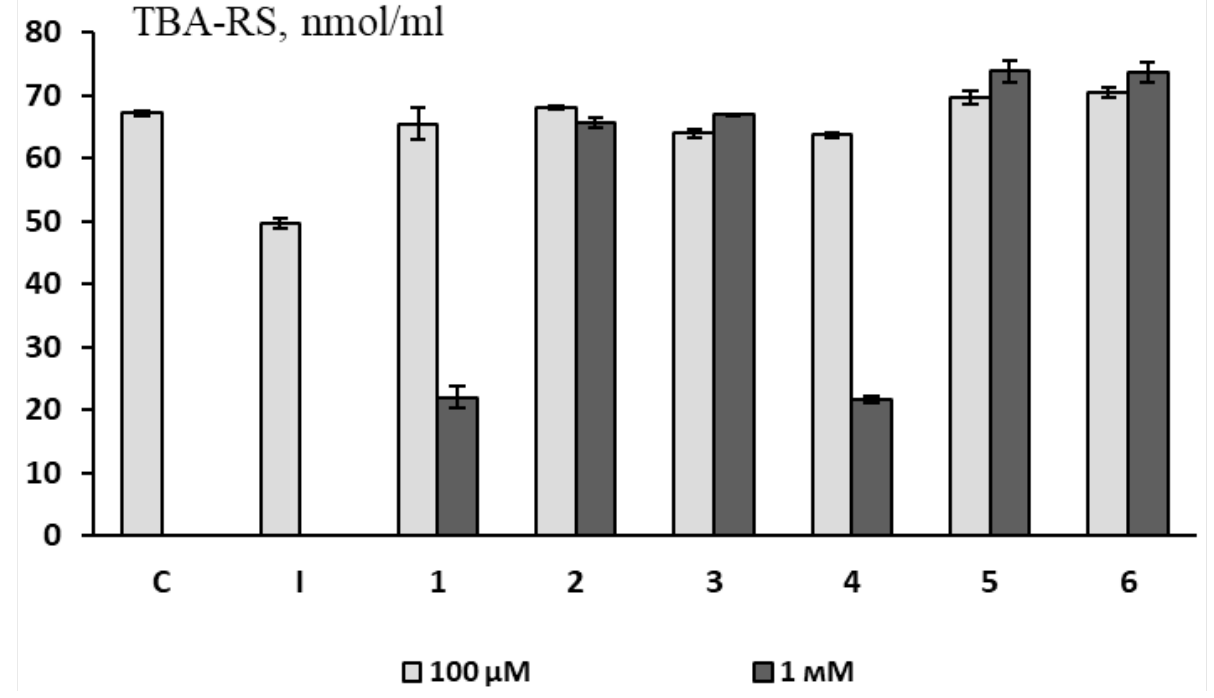
Figure 4. Effects of compounds 1–6 (100 µ M and 1 mM) on TBA-RS accumulation in mouse brain homogenates. TBA-RS concentrations were measured at 1 h after the initiation of LPO by Fe 2+ /ascorbate. C—control sample containing no test compounds; I—intact sample in which LPO was not initiated. Vertical bars: means ± SE ( n = 4–8).